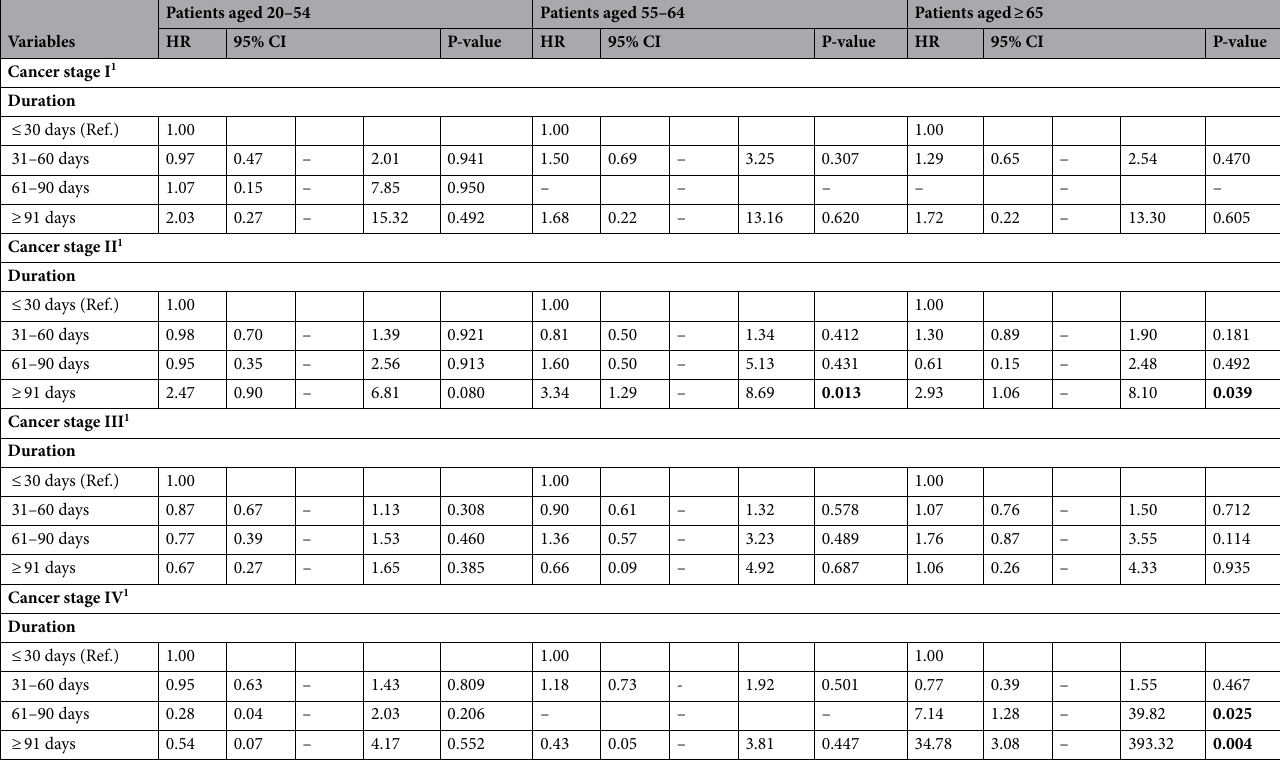
Table 3. Influence of DFTI on mortality risk in patients of different ages and at various breast cancer stages. 1 The related variables (marital status, education level, monthly salary, level of urbanization, CCI score, tumor